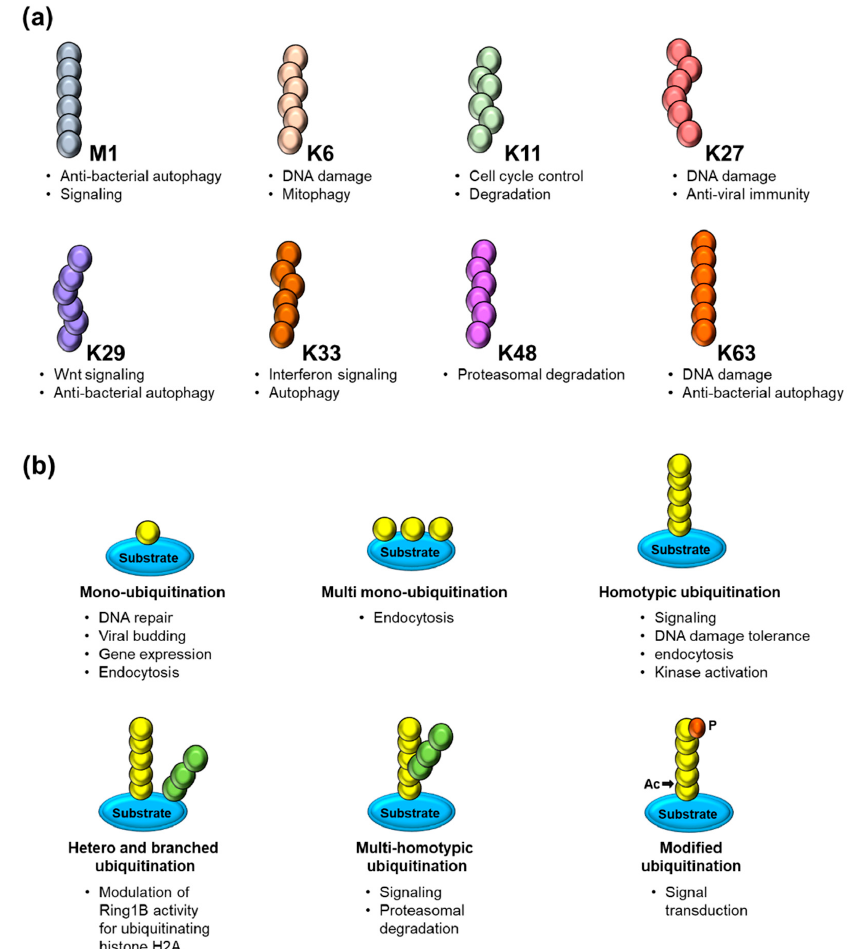
Figure 2. ( a ) Schematic representation of ubiquitin chains linked through methionine (M) 1 (linear/head–to–tail) or through the internal lysine (K) residues 6, 11, 27, 29, 33, 48 and 63 along with its respective cellular functions. ( b ) Overview of several modes of substrate ubiquitination including different forms of mono– and polyubiquitination and the PTMs of ubiquitin itself by acetylation (Ac) and phosphorylation (P) along with its respective cellular functions.